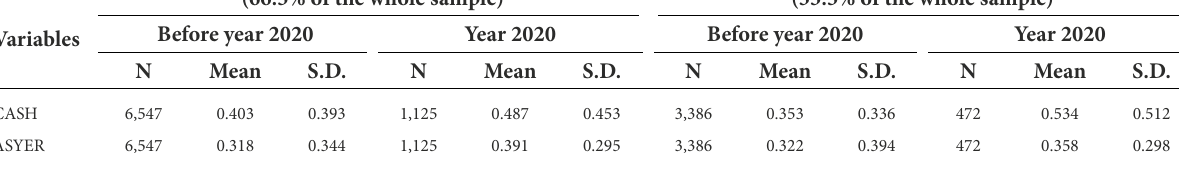
Panel C. Selected firm-level data of SOEs and